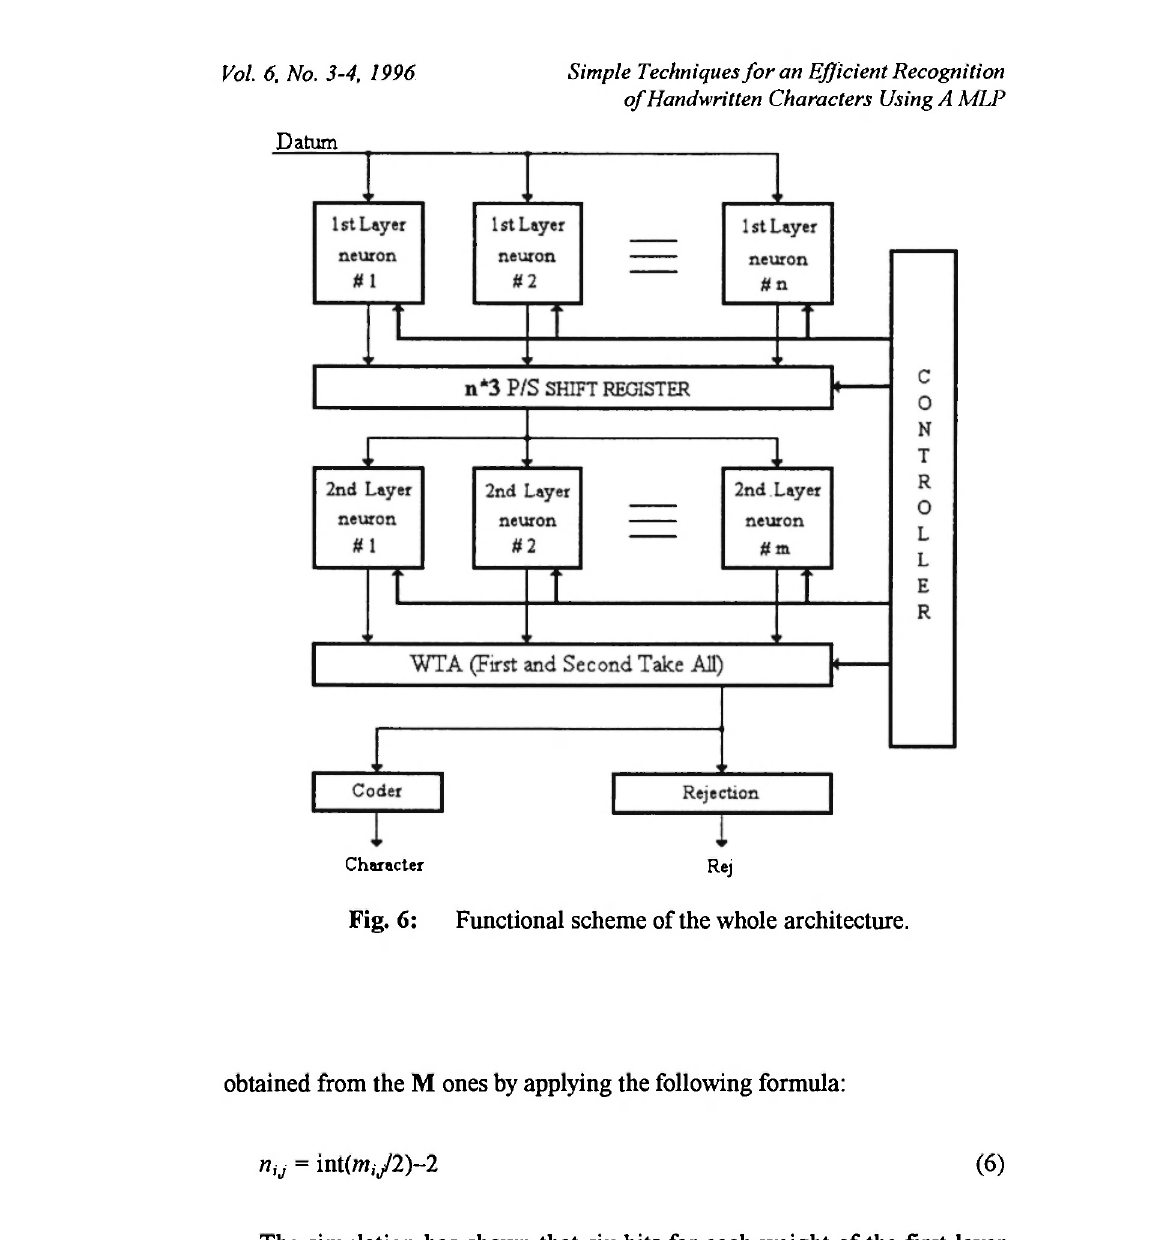
Fig. 6: Functional scheme of the whole